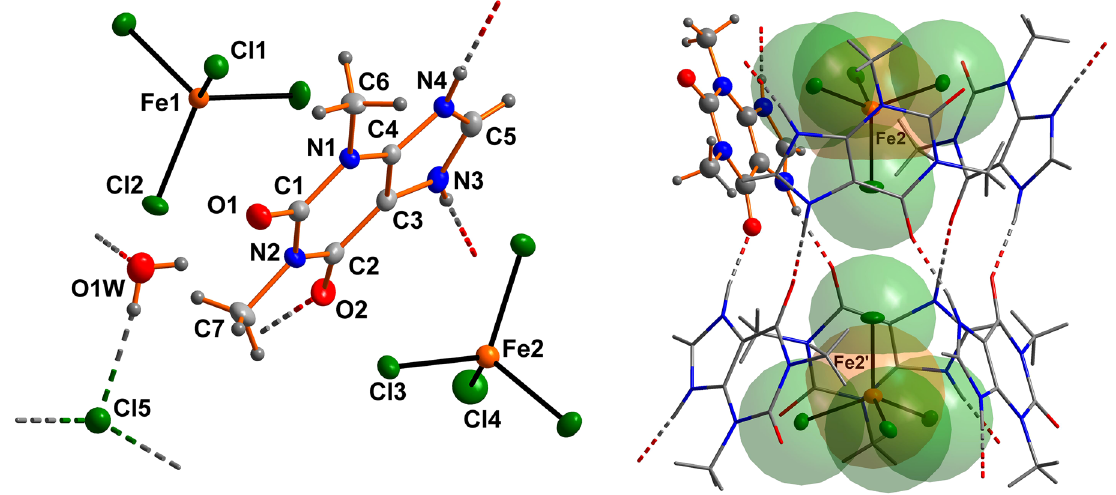
Table  : Data collection and handling.